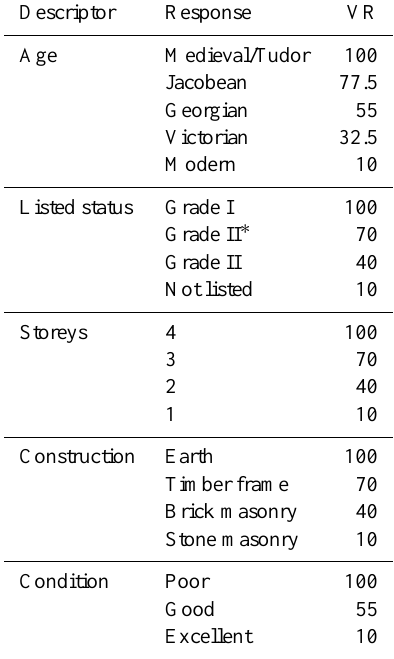
Table 1. Vulnerability descriptor